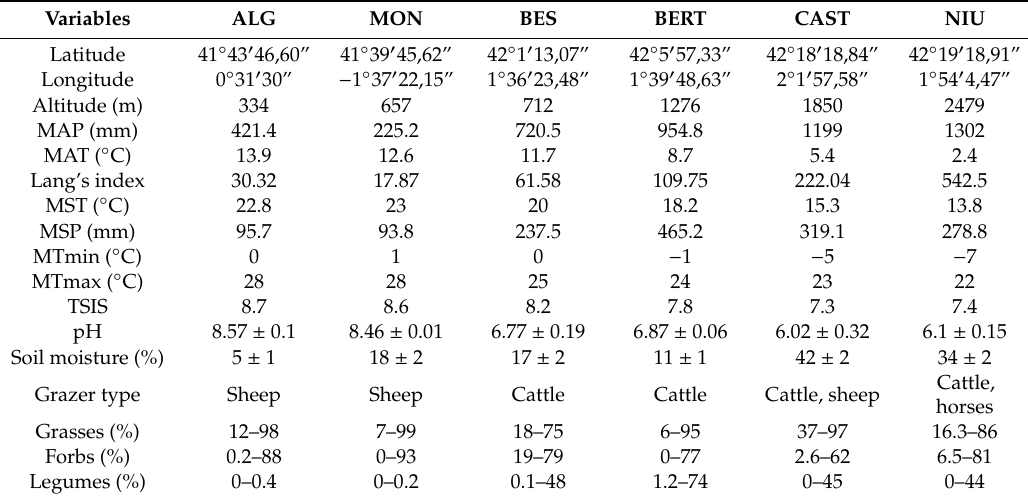
Sheep Cattle Cattle Cattle, sheep Legumes (%) 0–0.4 0–0.2 0–44